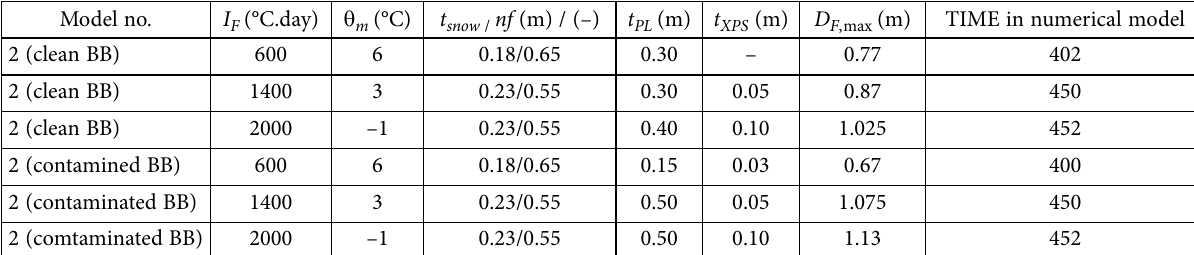
Table 6. Achieved depths of freezing of the railway track structure depending on the moisture of the protective layer and the quality condition of the ballast bed (its fouling) Model